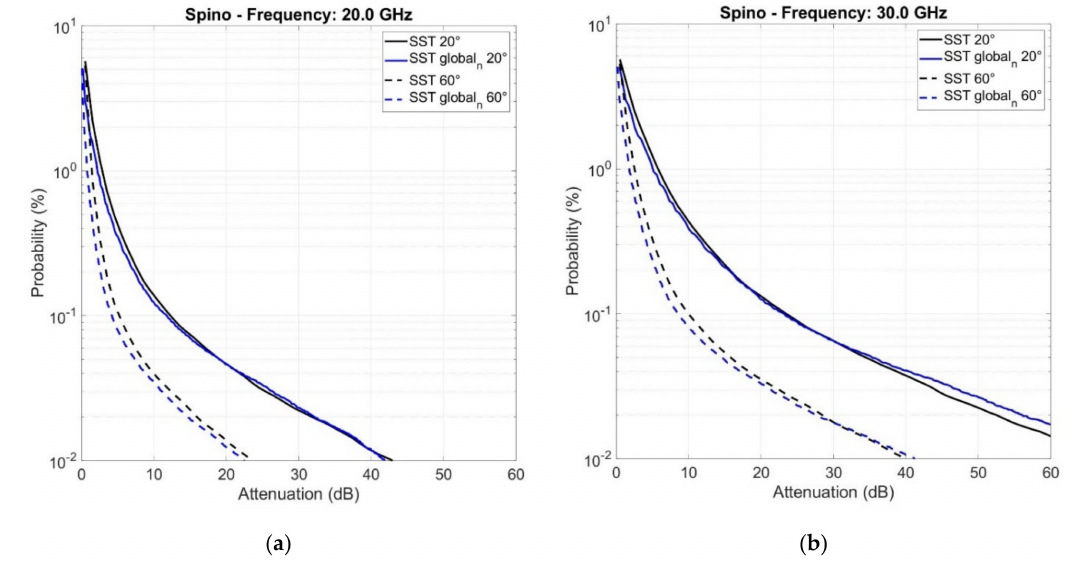
Figure 2. P SST ( A ) (black lines) and P SST , glo ( A ) (blue lines) at 20 GHz ( a ) and at 30 GHz ( b ) at Spino d’Adda, for θ = 20 ◦ (continuous lines) and θ = 60 ◦ (dashed